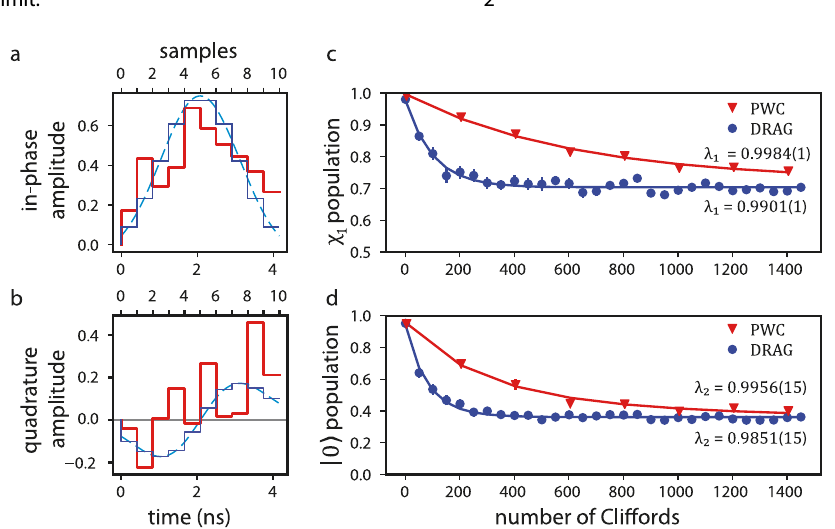
Fig. 4 Optimized pulse shapes at 4.16 ns and their leakage characterization. a In-phase and b quadrature amplitude component of the pulse envelope before (blue) and after the piecewise-constant optimization (red), as represented in AWG memory. The dashed lines indicate the analytical DRAG pulse shapes. c Remaining population in the computational subspace χ 1 for randomized benchmarking measurements using pulses based on the DRAG and optimized piecewise-constant pulses. The decay constant λ 1 characterizes the population remaining in χ 1 . d Full leakage RB analysis characterization using a double decay with decay constants